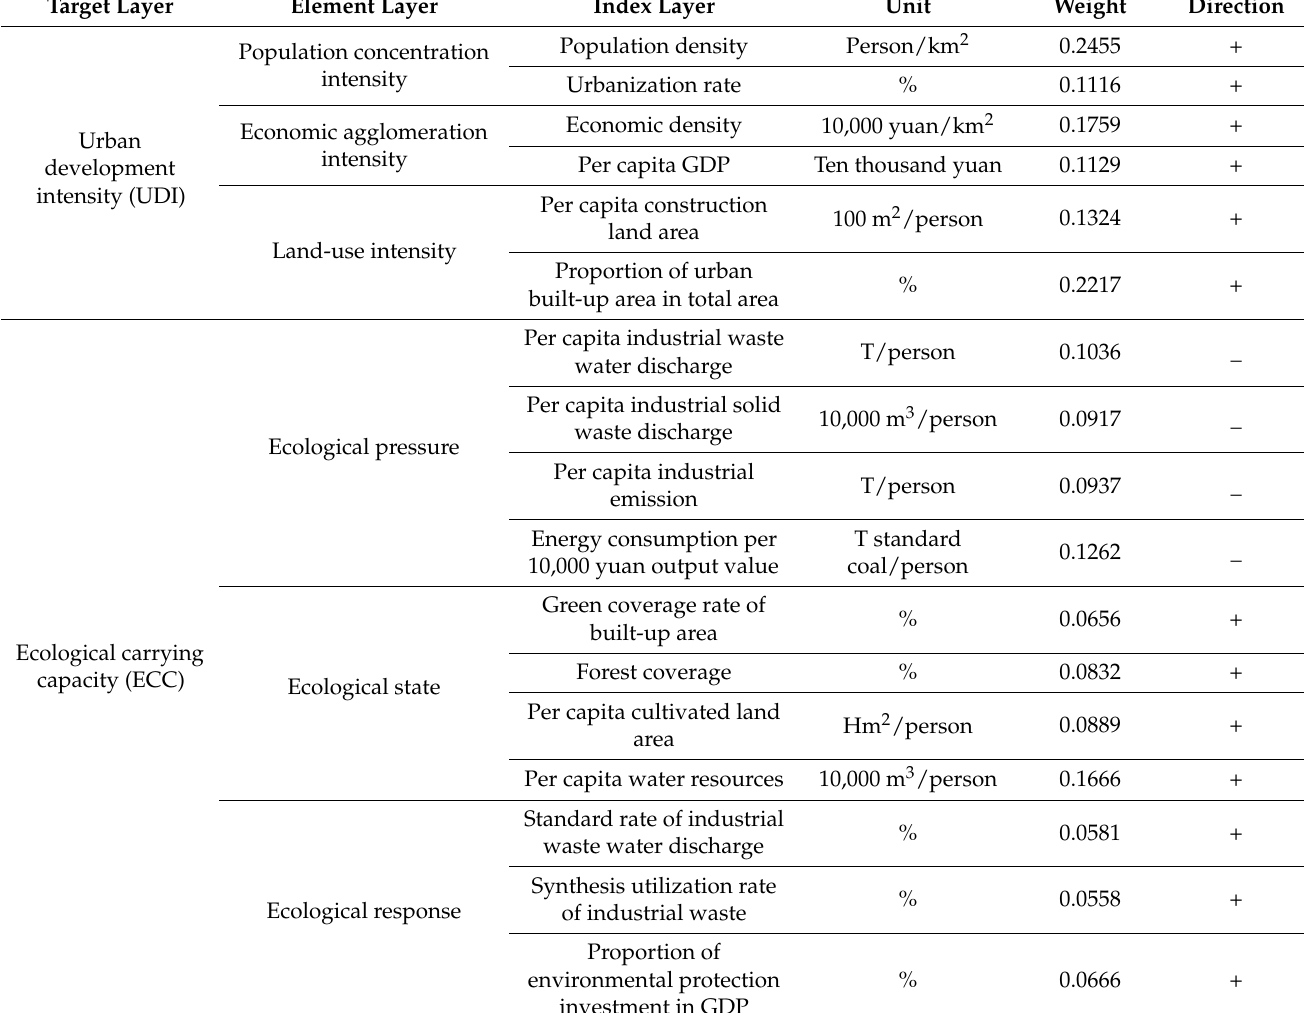
Table 1. Evaluation index system of UDI and